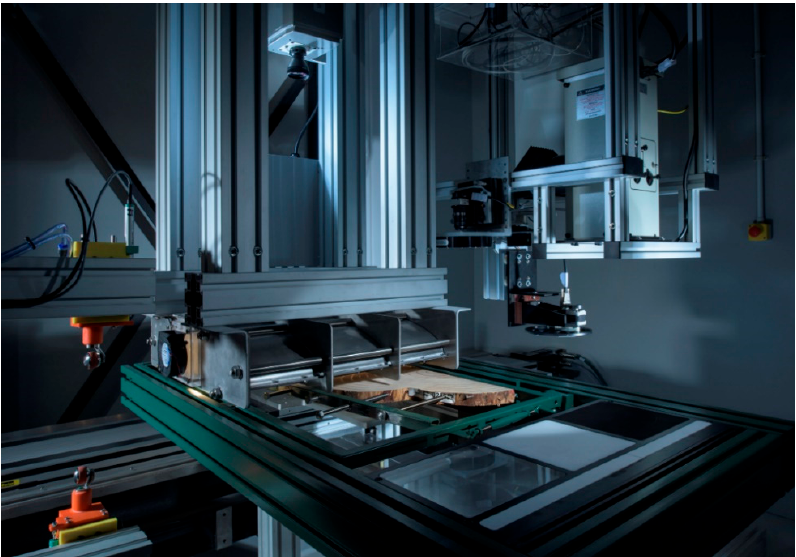
Figure 15. Scion’s (New Zealand Forest Research Institute Limited) DiscBot.